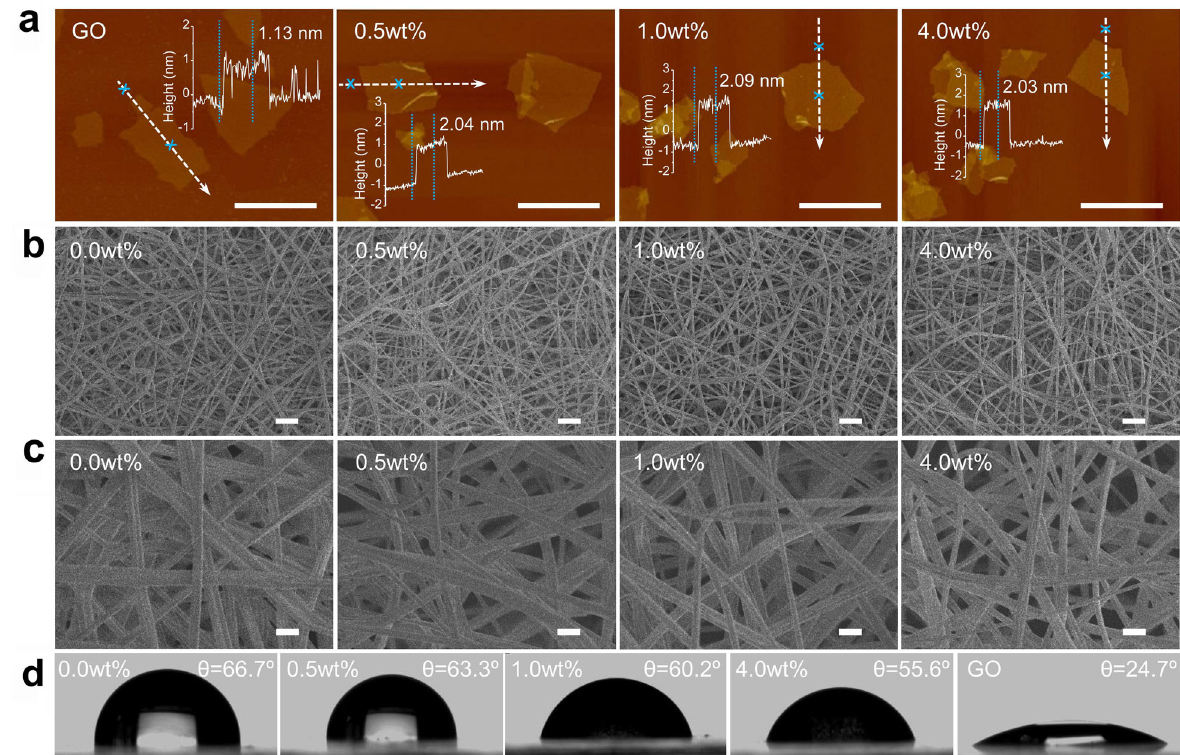
Fig. 1 Characterization of GO/PLLA nano fi ber scaffolds. a AFM images of GO nanosheets interacting with or without PLLA. b , c SEM images of GO/PLLA nano fi ber scaffolds. d Contact angle images of GO/PLLA nano fi ber